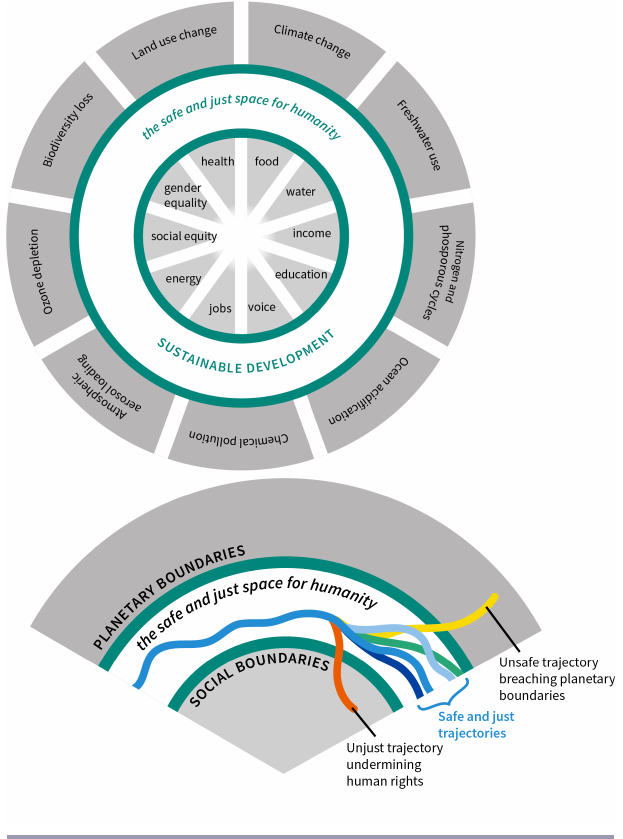
Fig. 1. Trajectories of sustainable development. Combining planetary and social boundaries creates a doughnut-shaped space within which humanity can thrive. Sustainable development can only take place within this so-called doughnut. Within this space, multiple trajectories of development are possible that contribute to the productive capacity of the biosphere to varying degrees and that more or less align with the needs, values, and aspirations of different groups of people. Illustration: E. Wikander/Azote, adapted from Raworth